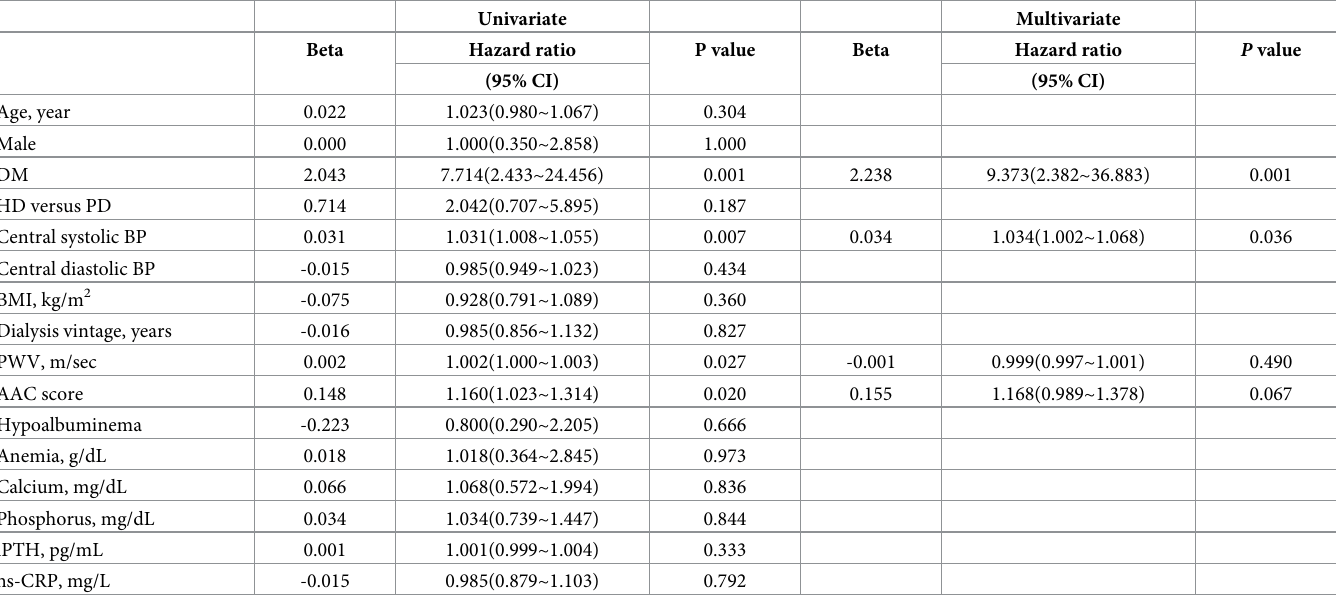
Table 3. Univariate and multivariate logistic regression analysis for LV diastolic